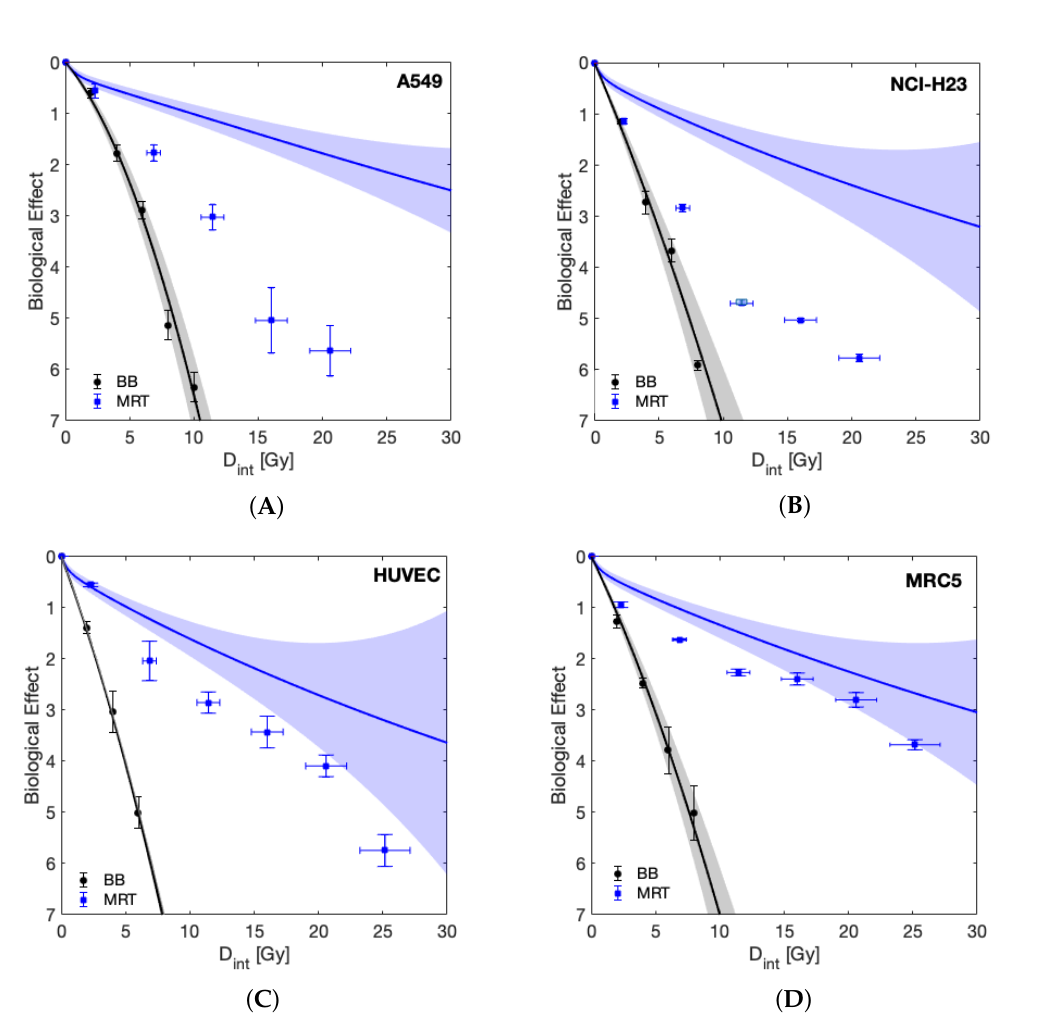
Figure 3. The experimentally measured biological effect of the investigated cell lines is plotted as a function of integral dose ( D int ) for BB and MRT together with the surviving fraction predicted by the LQ-model using BB parameters (solid lines). Shaded areas represent uncertainty due to LQ-model parameter fit uncertainty and dosimetric uncertainty, as indicated in Figure 1. Data are shown for the tumour cell lines A549 ( A ) and NCI-H23 ( B ), and normal cell lines HUVEC ( C ) and MRC-5 ( D